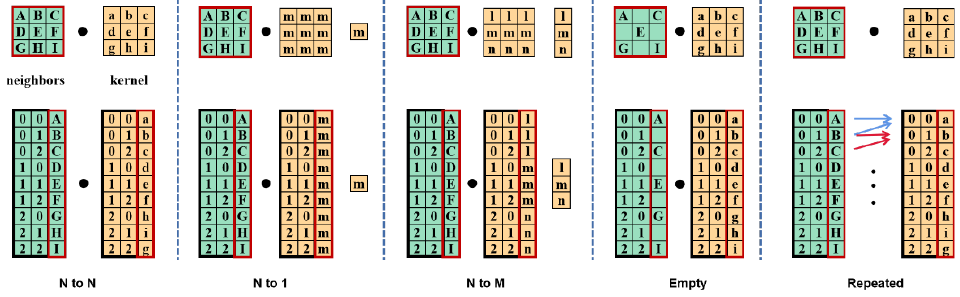
Figure 5. The types of correspondence for discrete convolution: N-to-N correspondence describes the standard image convolution; N-to-1 is used if the parameters are the same in all locations. The black circle is the convolution operation, the arrow are the correspondence. There are other correspondence types, e.g., N-to-M, etc.